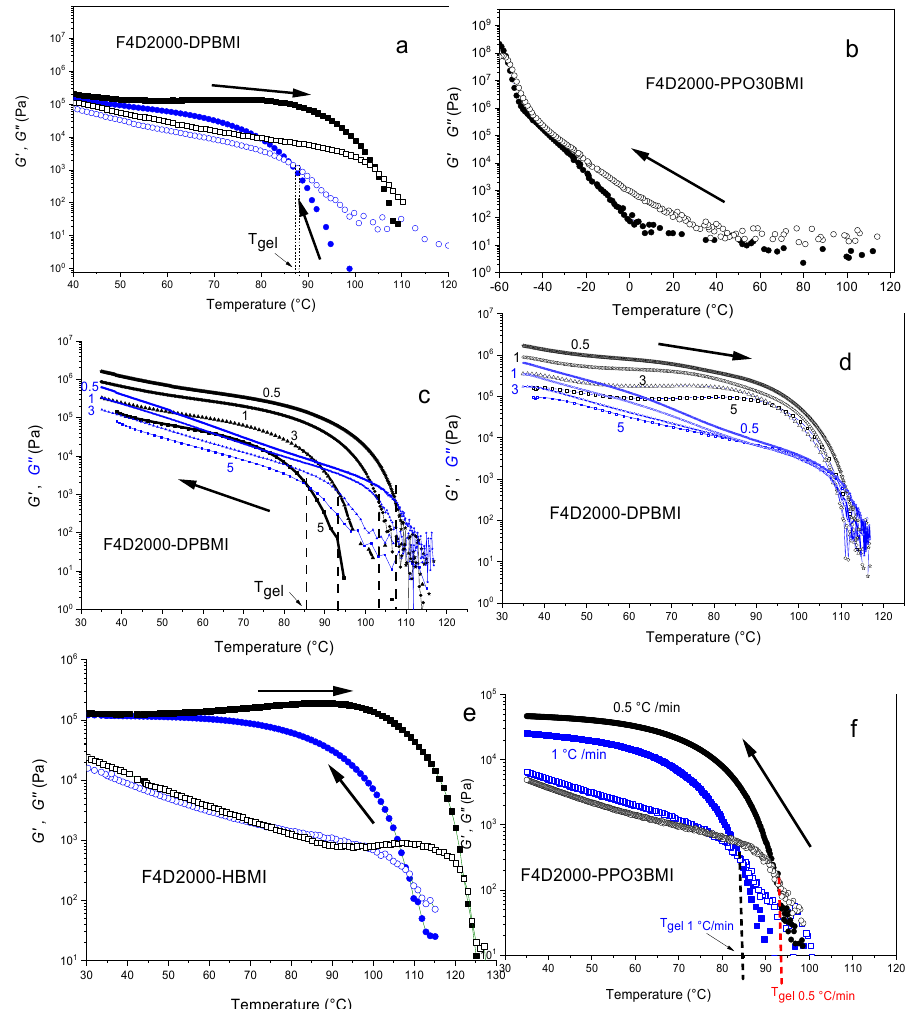
Figure 4. Storage G’ ( ● ) and loss G” ( ○ ) moduli of DA networks as a function of temperature duringcooling of the split-up structure and subsequent heating scans at di ff erent cooling / heating rates v exp. ( a ) F4D2000–DPBMI, v exp = 5 ◦ C / min, two dotted lines show di ff erence between T gel determined from crossover of moduli and from (tan δ ) gel = 1.5, ( b ) F4D2000–PPO30BMI, 1 ◦ C / min, ( c ) F4D2000–DPBMI cooling, rates v exp are indicated, ( d ) F4D2000–DPBMI heating, rates v exp are indicated, ( e ) F4D2000–HBMI, 3 ◦ C / min, and ( f ) F4D2000–PPO3BMI cooling, rates v exp are